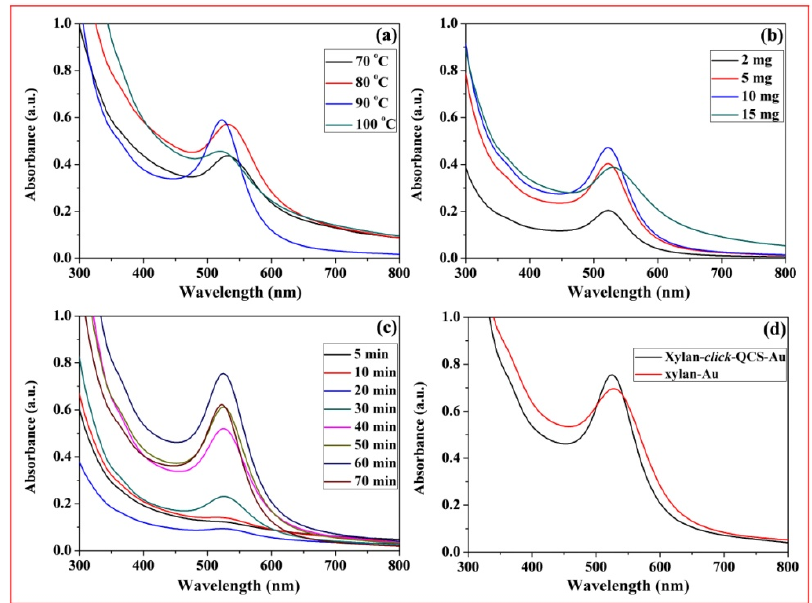
Figure 8. UV-Vis spectrum curves of Xylan-click-QCS/AuNP composites under different reaction conditions: ( a ) different reaction temperature; ( b ) different HAuCl 4 ·4H 2 O content; ( c ) different reaction time; ( d ) comparison of UV-vis spectrum curves of Xylan-click-QCS/AuNP composites and xylan /AuNP composites.